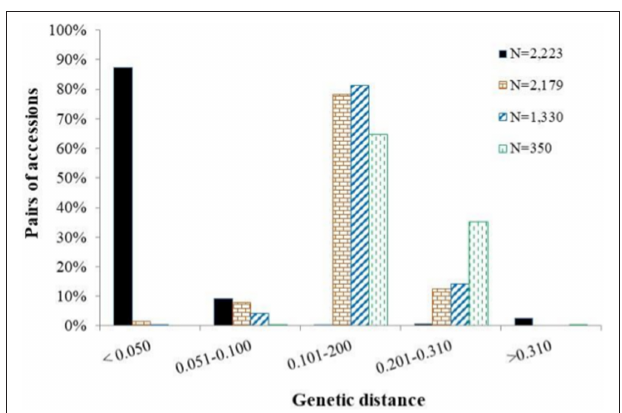
FIGURE 1 | Frequency distribution categories of pairwise genetic distance of 2,223 O. glaberrima accessions based on 16, 532 SNPs (black fill); 2,179 accessions (after excluding the 44 most diverse accessions) based on 3,834 SNPs (orange brick fill); a core set of 1,330 accessions (blue diagonal line fill) based on 3,781 polymorphic SNPs, and a mini-core set of 350 accessions (green dashed line fill), based on 3,709 polymorphic